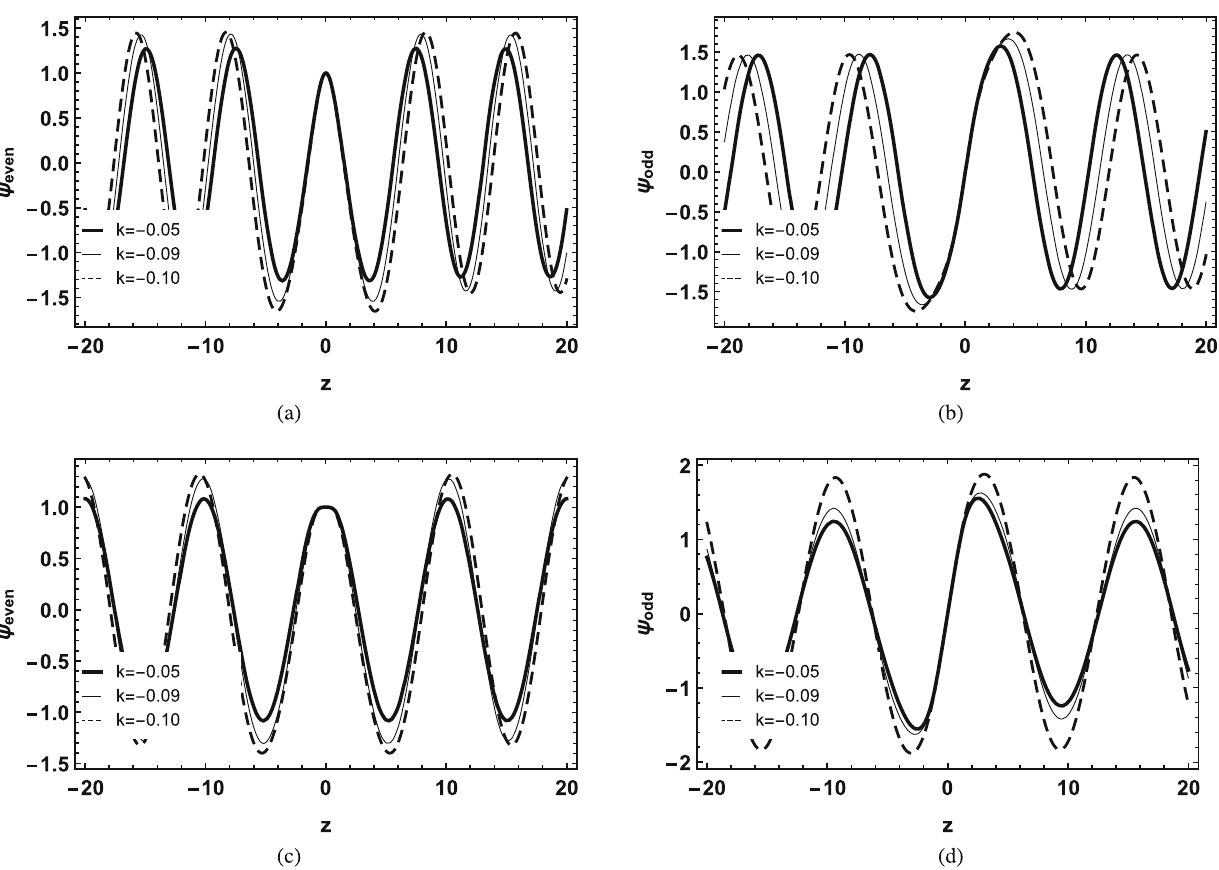
Fig. 10 The behavior of massive modes for G 2 (φ) , with n = 2, b = 4 and p = λ = 1. To the Gauge field, a ψ e v en with m = 0 . 847. b ψ odd with